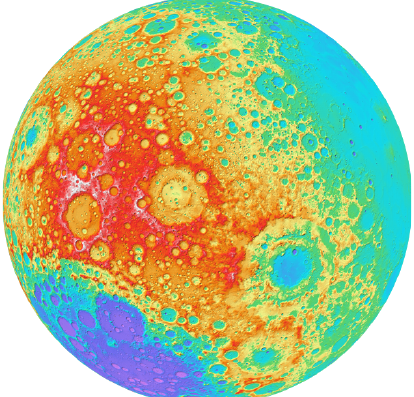
Figure 2. Orthographic view of the WAC Shaded Relief centered at 240° E longitude and 0°